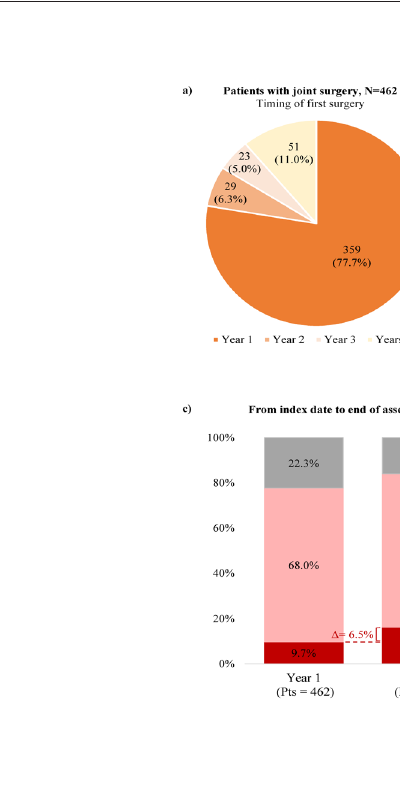
Figure 2. Surgical Patterns: (A) Distribution of First Surgeries Post-TGCT Diagnosis; (B) Distribution of Repeat Joint Surgeries Post-TGCT Diagnosis; (C) Cumulative Distribution of the Number of Joint Surgeries a During Follow-up